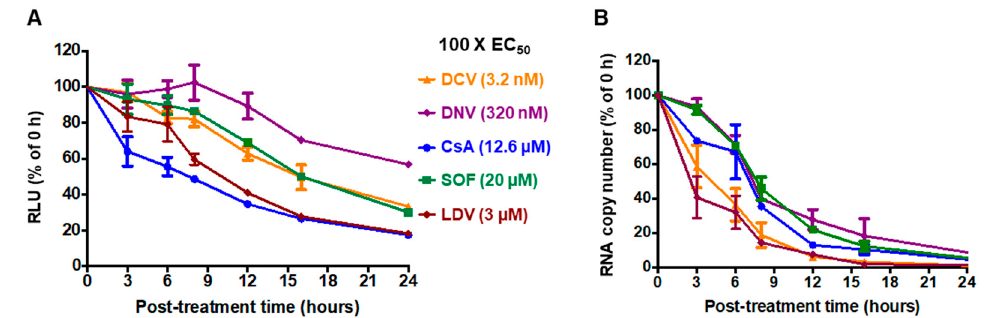
Figure 1. Time course of HCV inhibition by antivirals. Huh-7.5.1 cells were infected with Jc1/Gluc2A at an MOI of 0.5 for 48 h and then treated with 100 × EC 50 of the indicated compounds. ( A ) Culture supernatants were analyzed for luciferase activity at the indicated time points. ( B ) The total cellular RNA sample was extracted using TRIzol reagent and analyzed for HCV 5 ′ UTR RNA by RT-qPCR at the indicated time points. The data were normalized to a DMSO-treated control. Each data point represents an average value of 3 individual experiments. The error bars represent the standard errors of the mean (SEMs). DCV, daclatasvir; DNV, danoprevir; CsA, cyclosporin A; SOF, sofosbuvir; LDV, ledipasvir.